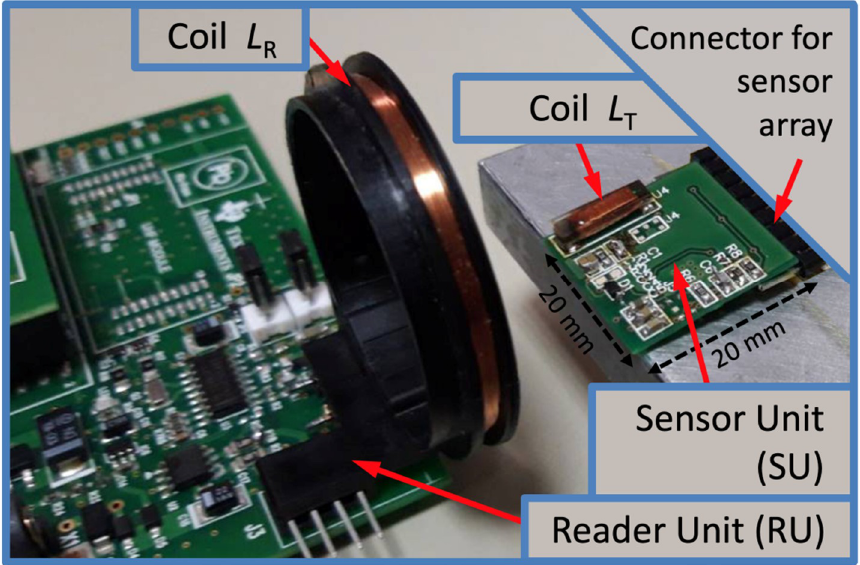
Figure 5. Picture of the developed system composed of the reader unit and the contactless interface.